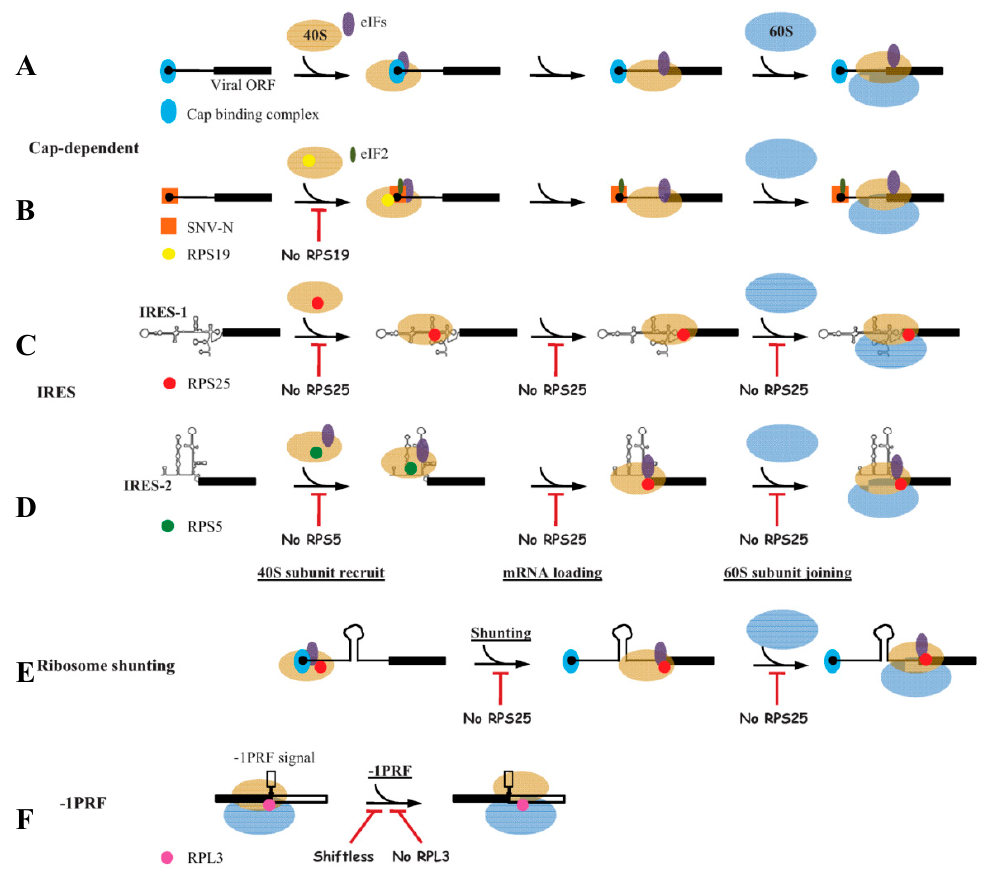
Figure 1. Models for the roles of ribosomal proteins (RPs) in regulating viral mRNA translation initiation. ( A ) Cap-dependent translation initiation, in which cap-binding complex (eIF4F) and eukaryotic initiation factors (eIFs) are required; ( B ) N protein of Sin nombre hantavirus (SNV) interacts with RPS19 to recruit 40S subunit to 5 (cid:48) cap, directly mediating viral mRNA translation initiation independently of cap-binding complex; ( C ) The internal ribosome entry site 1 (IRES-1) (from IGR of Dicistroviridae family) depends on RPS25 for 40S subunit recruitment, mRNA loading and 60S joining, and no eIFs are required in this process; ( D ) IRES-2 (from hepatitis C virus) relys on RPS5 to bind 40S subunit with the participation of eIFs, and RPS25 is required in subsequent mRNA loading and 60S joining process; ( E ) In ribosomal shunting, RPS25 is also indispensable; ( F ) In programmed -1 ribosomal frameshifting (-1PRF), RPL3 controls translational fidelity. Shiftless inhibits -1PRF via interacting with RPS27A, RPL11 and release factors. Legends are annotated in the figure. eIFs (purple) refer to various eIFs, which are di ff erent in di ff erent steps. Underlined text indicates di ff erent steps in the viral translation. Italics “No RPS25” indicates the depletion or knockout of this RP, and the rest is the same. Red T-shaped symbol represents the block of the step. The secondary structures of IRES-1 and IRES-2 are schematic, and do not represent the real stem-loops.